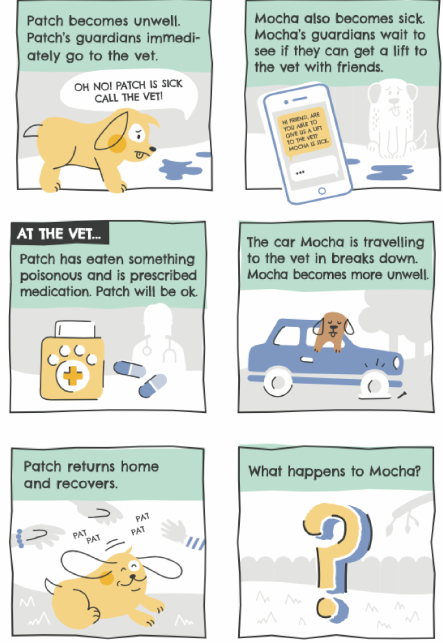
Figure 2. Story of Two Tails: exploring the influence of the social determinants of health on companion animals. Inspired by The Pencilsword: On a plate